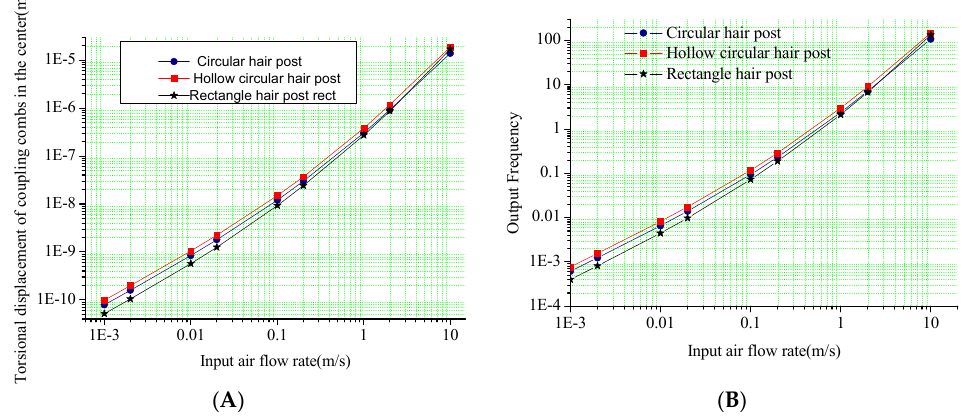
Figure 5. The signal outputs in the input of air flow rate along the x -axis. ( A ) Output torsional displacement versus air flow rate; ( B ) Output frequency versus air flow rate. Table 4. Performance comparison of three kinds of hair structure. Circular Hair Post Hollow Circular Hair Post